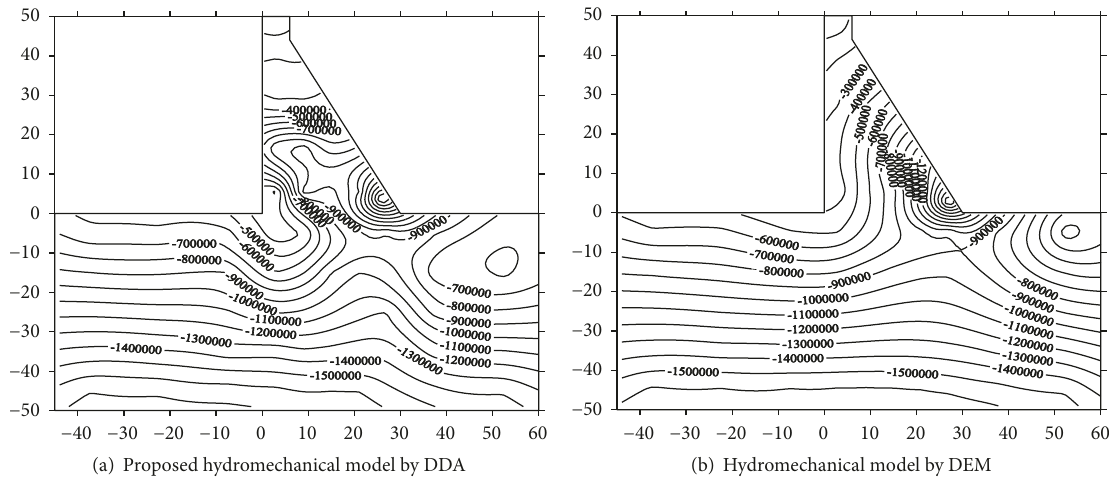
Figure 6: Maximum principle stress contours under coupling